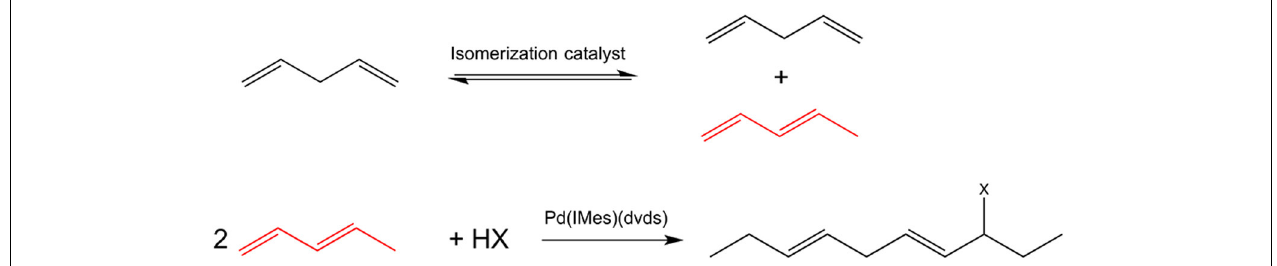
FIGURE 1 | A scheme of a tandem isomerization—telomerization of long-chain dienes for the case of pentadienes; the isomer selectively participating in the telomerization reaction is shown in